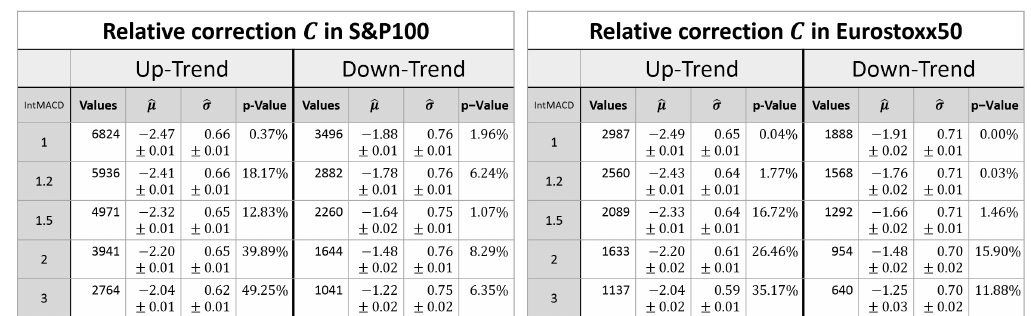
Table 7. Parameters of the log-normal fit for the relative correction in up- and down-trends. ( a ) S&P100 data. ( b ) Eurostoxx50